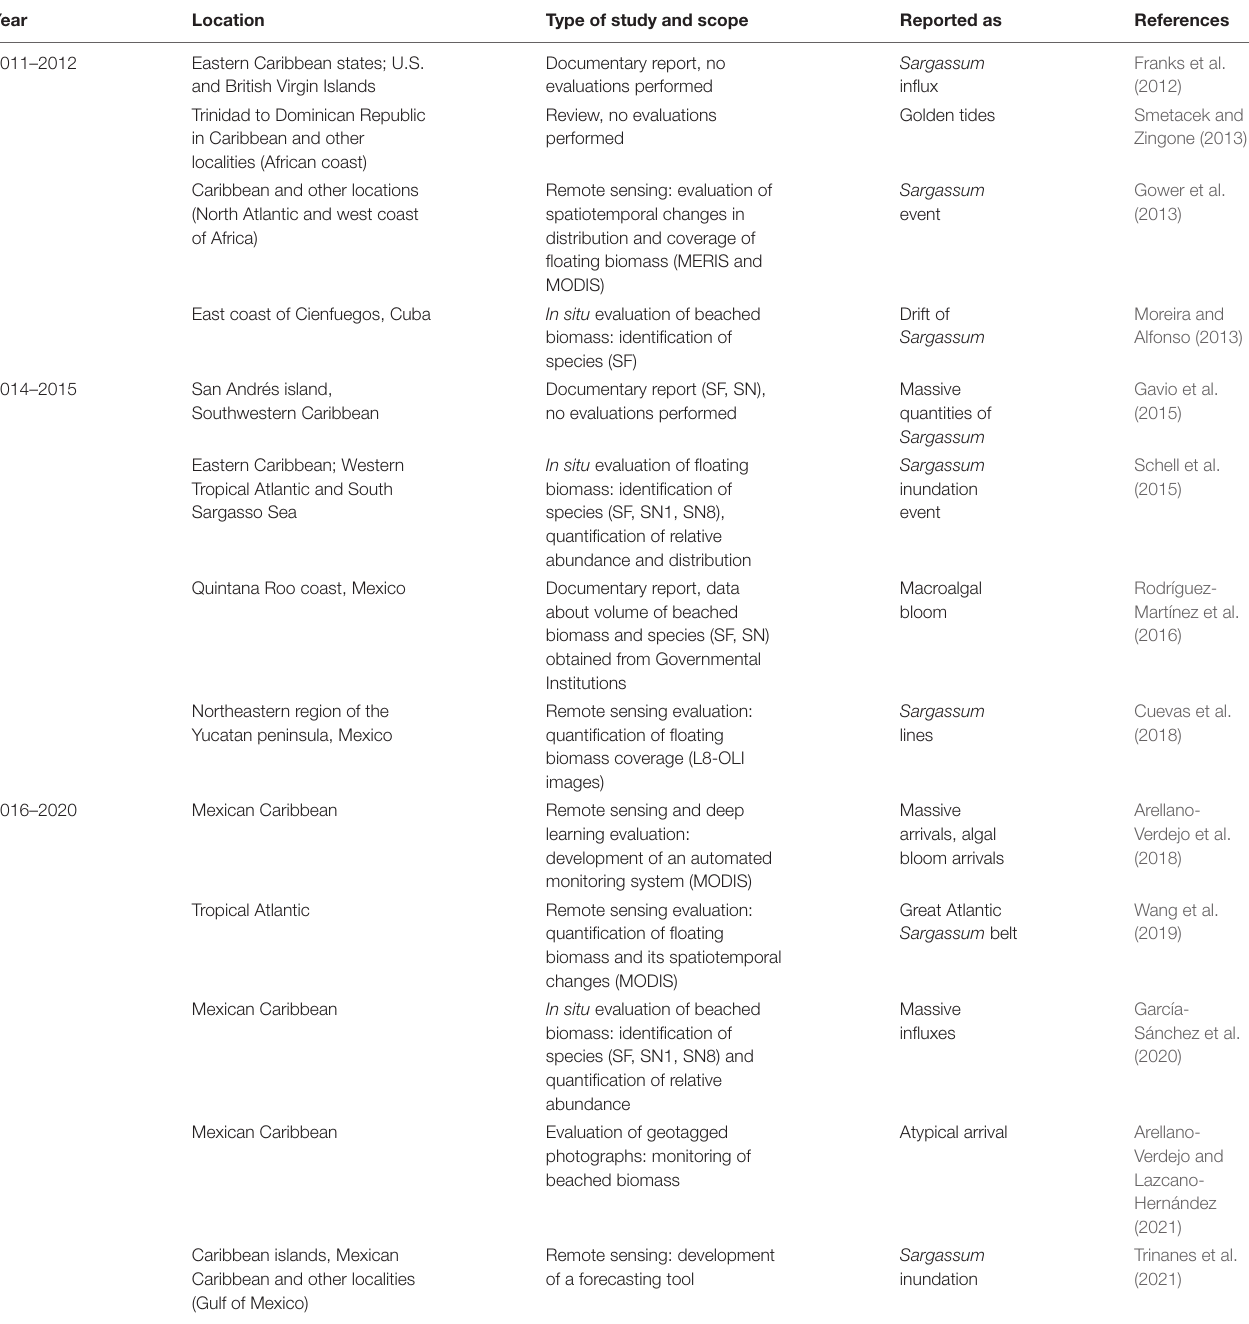
TABLE 1 | Sargassum events reported for the Caribbean region. Location, scope of the study and term used to describe the